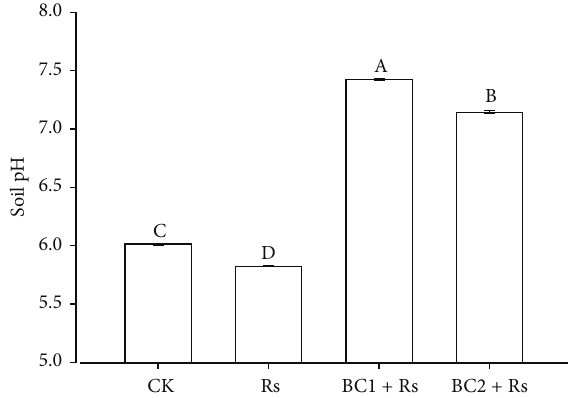
Figure 8: Effects of treatment on soil pH. CK, no biochar and no R. solanacearum inoculation; Rs, R. solanacearum inoculation; BC1 + Rs, peanut biochar amendment and R. solanacearum inoculation; BC2 + Rs, wheat biochar (BC2) amendment and R. solanacearum inoculation. Different letters on the columns denote a significant difference at 𝑃 < 0.05 using the DMRT (Duncan’s new multiple range tests)